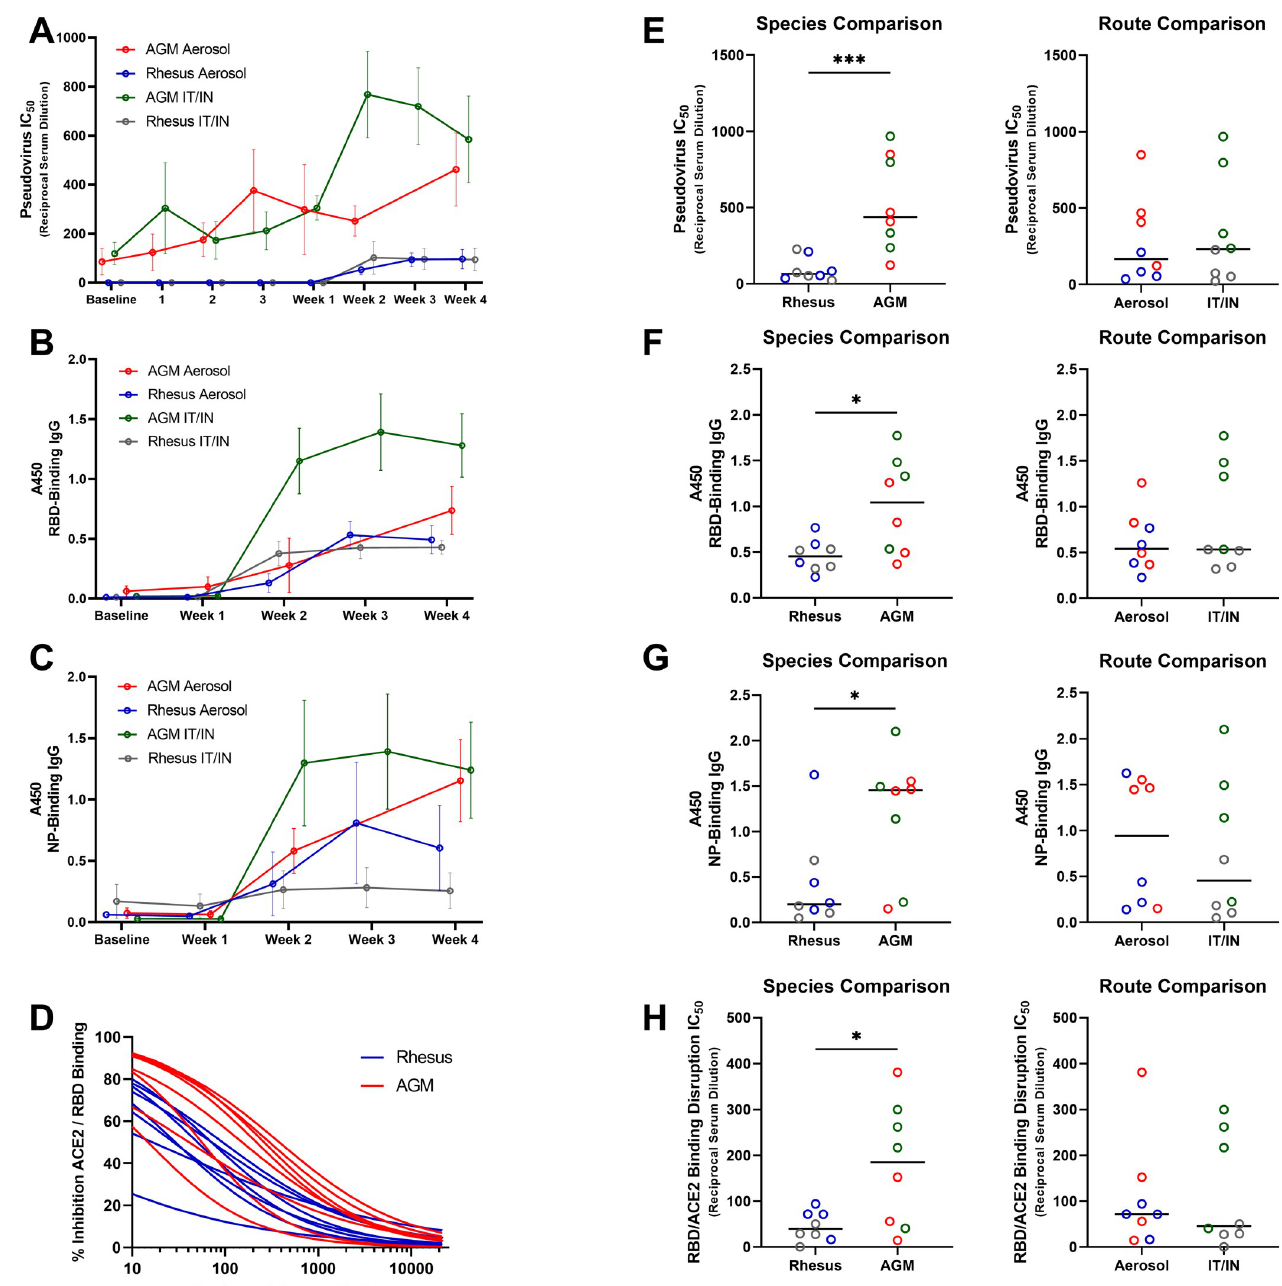
Fig 3. Antibody Responses to SARS-CoV-2 Challenge. Antibody responses were followed post challenge by A)pseudovirus neutralization, B and C) ELISA for binding to RBD and NP, respectively, and D) surrogate virus neutralization test at necropsy. Route and species variability in antibody levels at time of necropsy were compared for each assay type (E-H). Comparisons were made using the Mann-Whitney or Welch’s t-test, depending on normality of data. Asterisks represent significant comparisons ( � , p < 0.05; ��� , p < 0.001). https://doi.org/10.1371/journal.ppat.1010618.g003 BAL and serum cytokines Measurements of cytokines in serum and BAL supernatant samples were performed through- out the study. Cytokines in the BAL supernatant was more differentially expressed than those